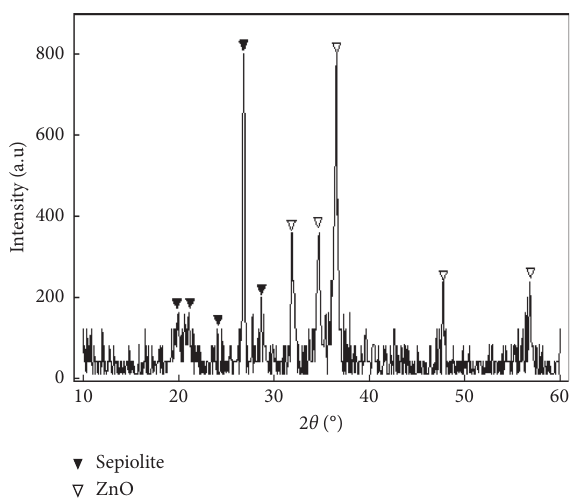
Figure 22: XRD pattern of the ZnO/sepiolite composite prepared by the hydrothermal reduction method.